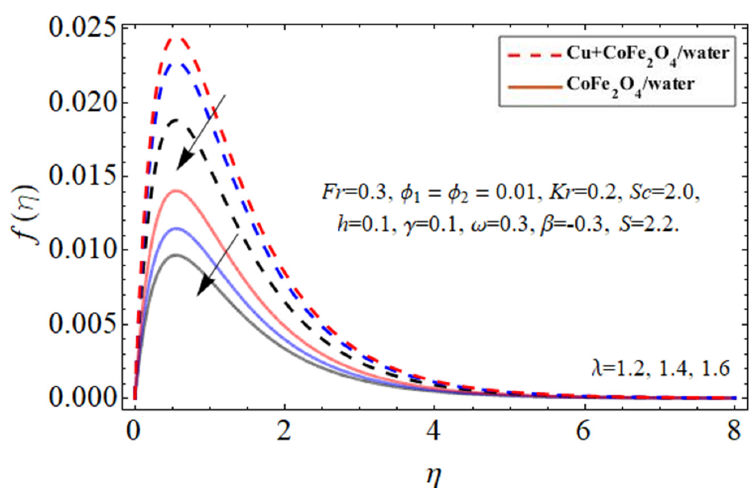
( ) η ( ) η f f against porosity parameter . λ Figure 5. The behavior of primary velocity f ( η ) against porosity parameter λ . against porosity parameter . λ